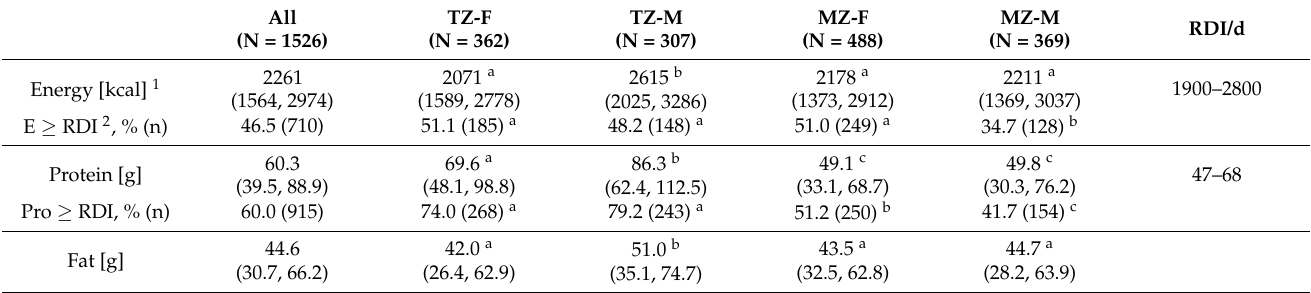
Table 2. Macro- and micronutrient intake of the farmers in comparison to recommended